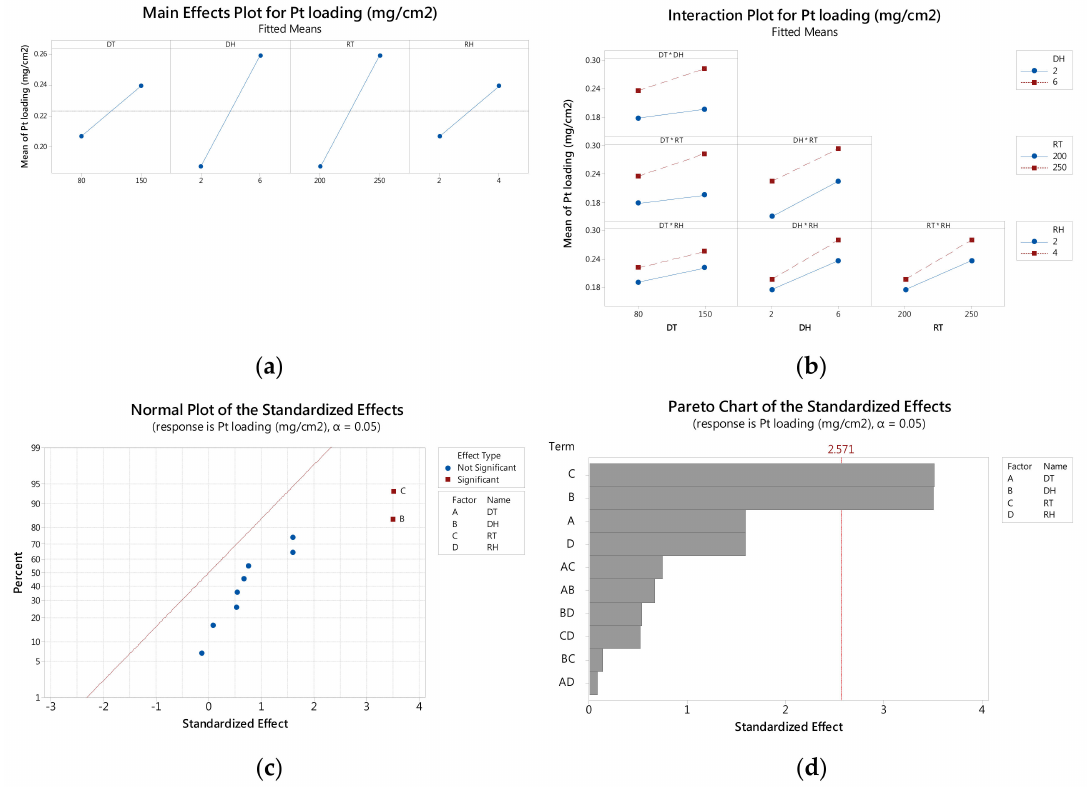
Figure 4. The factorial design plots of Pt loading on the Pt/carbon paper composite prepared by SCD: ( a ) main effects plot of response; ( b ) interaction plot of response; ( c ) normal plot of the standardized effect; and ( d ) Pareto chart of the standardized